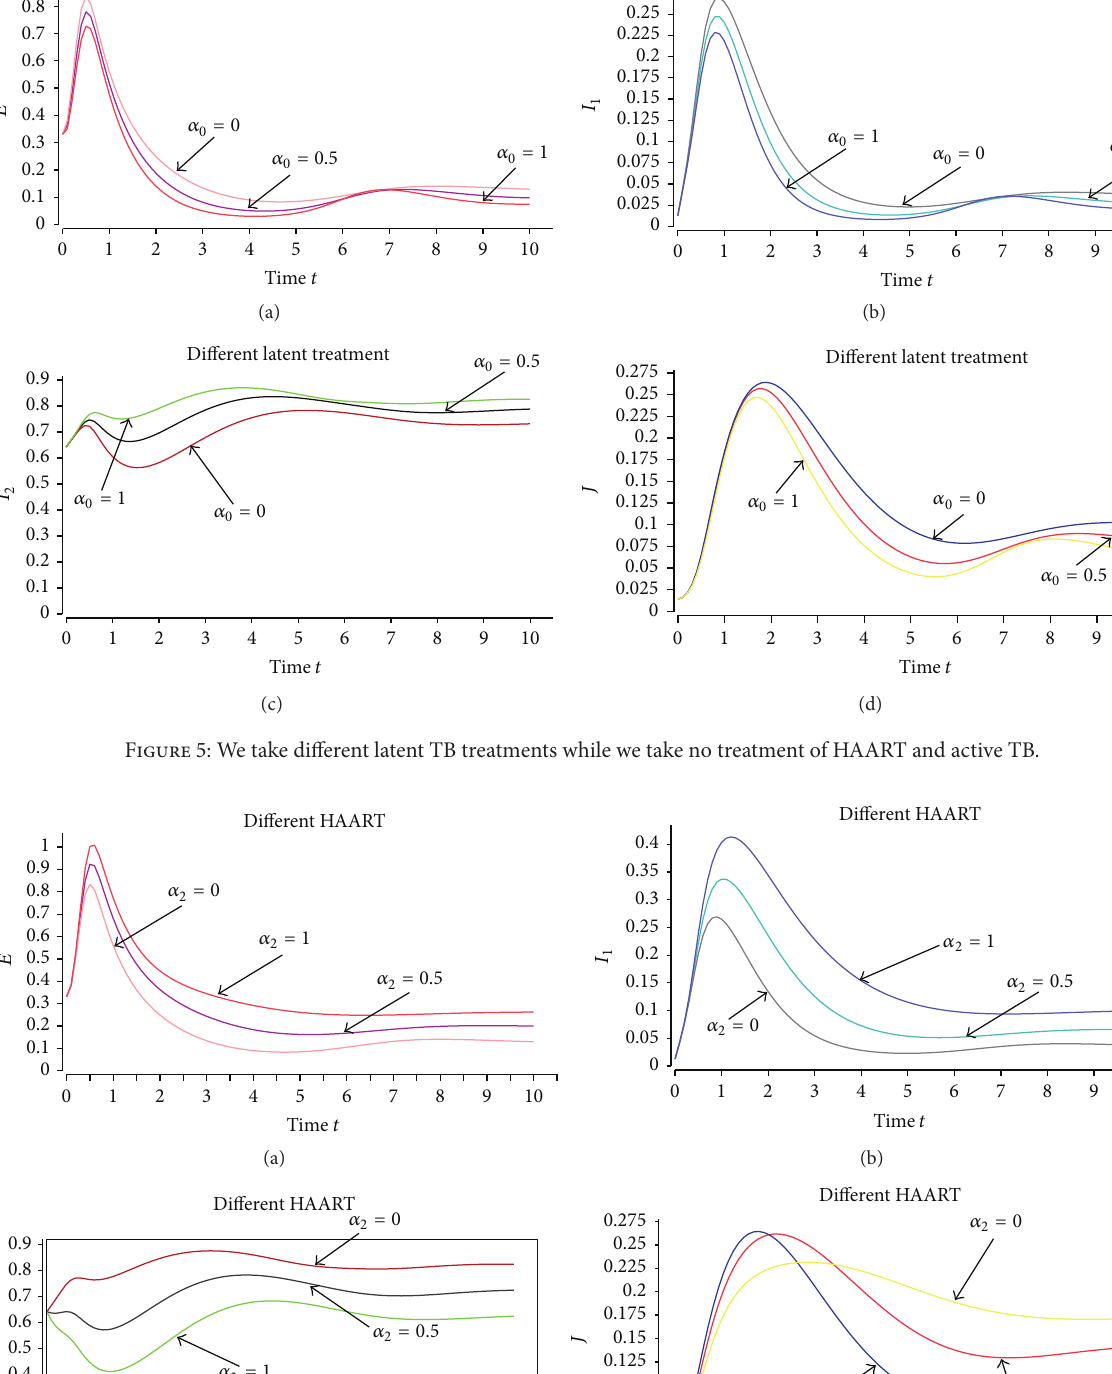
Figure 6: We take different HAART while we take no treatment of